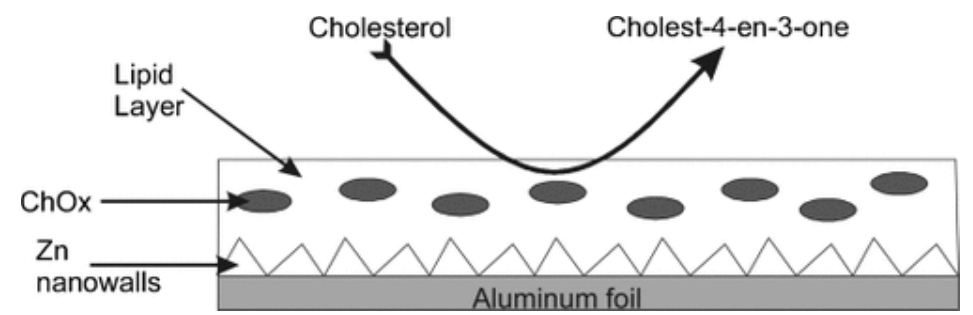
Figure 7. A simple diagram of the device design (from [75] with permission).